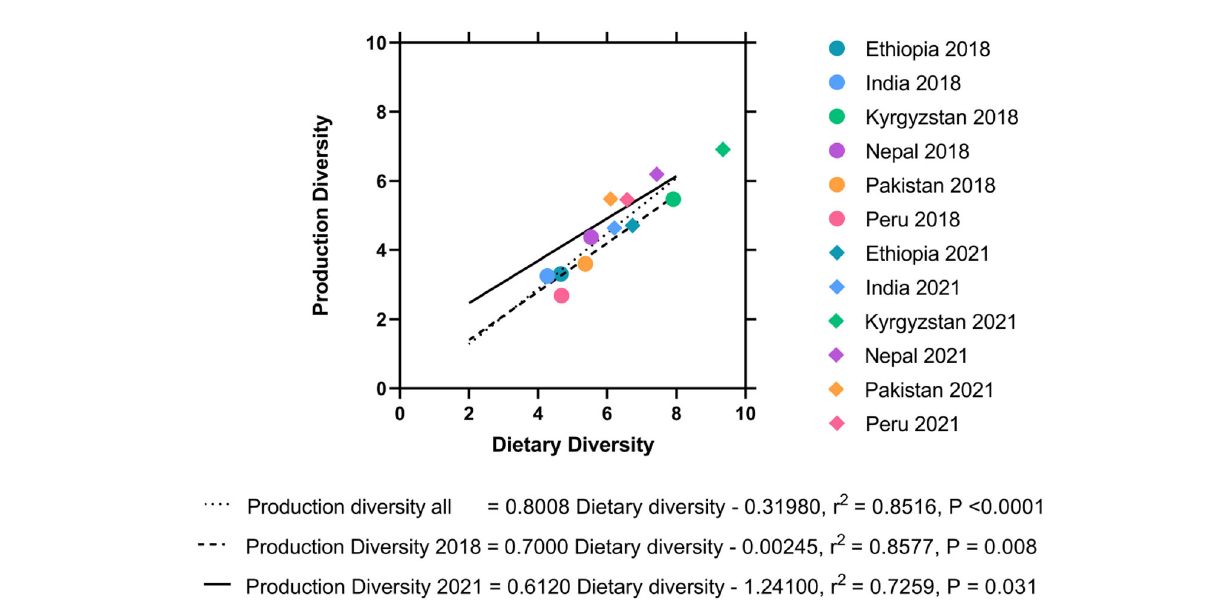
FIGURE5 Relationship between the average number of produced and consumed food groups (from 10 food groups as per minimum dietary diversity for women survey) before (2018) and after (2021) implementing the SUNSAIs in different project